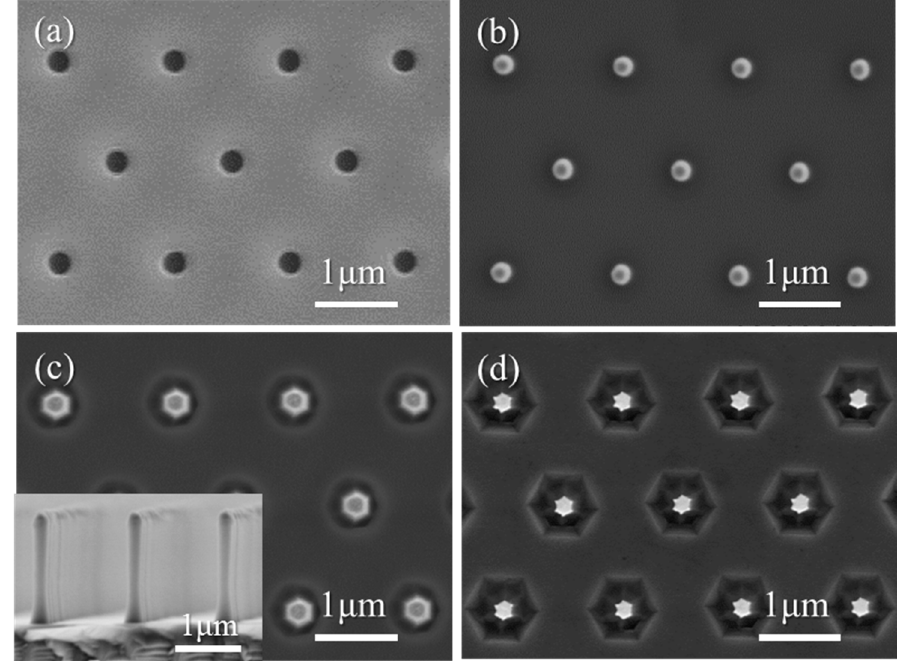
Figure 1. Secondary-electron plan-view SEM images of ( a ) the hole pattern in resist after DTL exposure and development, ( b ) the AlN template surface with the Au/Ni metal dot mask after lift-off, and ( c ) after Cl 2 /Ar plasma etching and ( d ) after AZ400k wet etching. The inset displays a cross-section image of the nanorod after Cl 2 /Ar plasma etching.